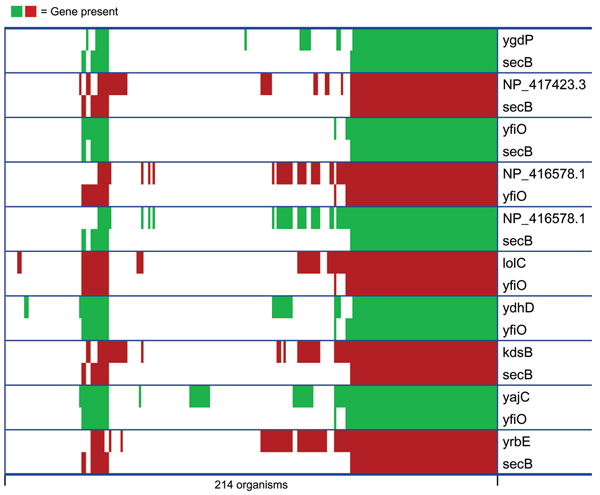
Profile pairs preferred by the unweighted hypergeometric metric without runs. Shown are the top 10 pairs of profiles that score highly in unweighted hypergeometric p-value but poorly in the runs-informed metric as determined by smallest ratios of unweighted hypergeometric p-value without runs to our runs-using score (taking both on a linear and not on a logarithmic scale). Not surprisingly, the matches between these profiles are concentrated in few runs. We find that the protein pairs here are not closely related functionally according to our snapshot of GO, and so they are likely false positives for the runs-oblivious unweighted hypergeometric model.